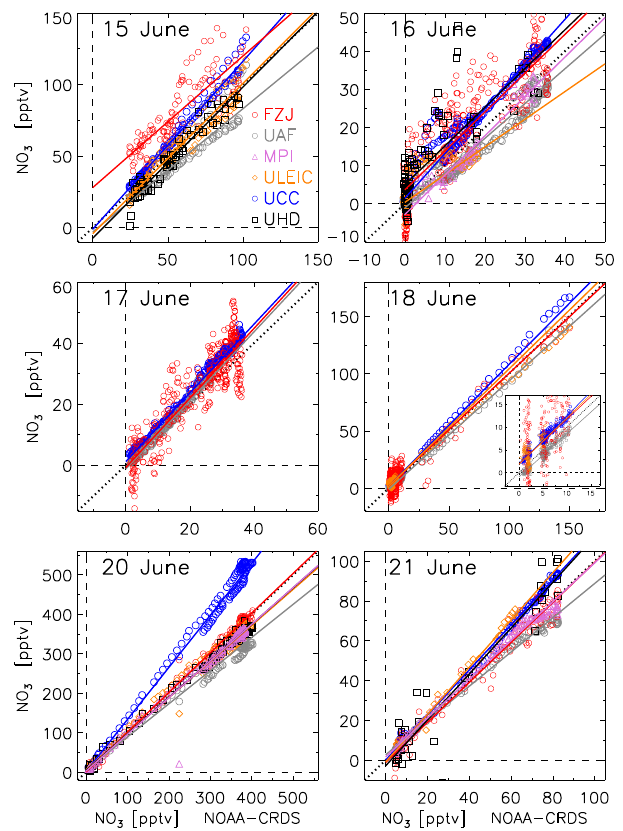
Fig. 8. Continued from Fig. 7. Inset on 18 June: NO 3 mixing ratios in the presence of isoprene (08:00–14:00UTC (NO 3 < 3pptv) and 16:10–24:00UTC (NO 3 <